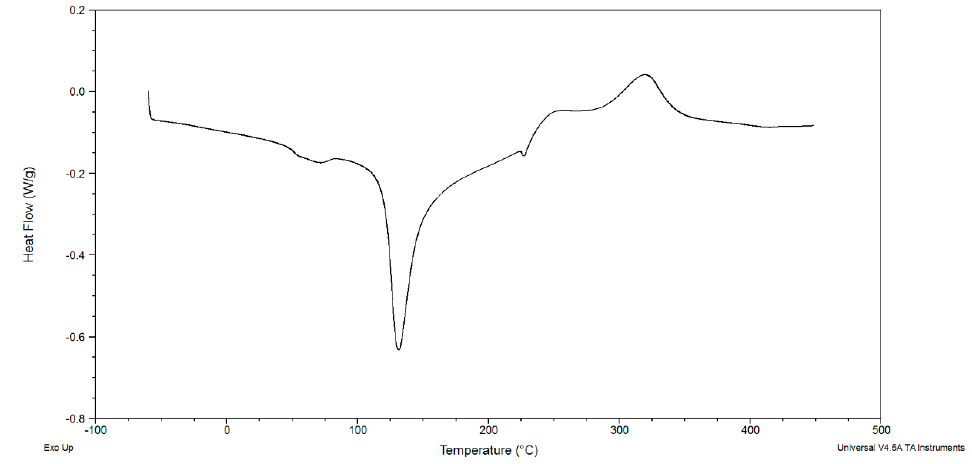
ff erential scanning calorimetry (DSC) curve of co ff ee silverskin Figure 1. Differential scanning calorimetry ( DSC) curve of coffee silverskin sample. Figure 1. Di